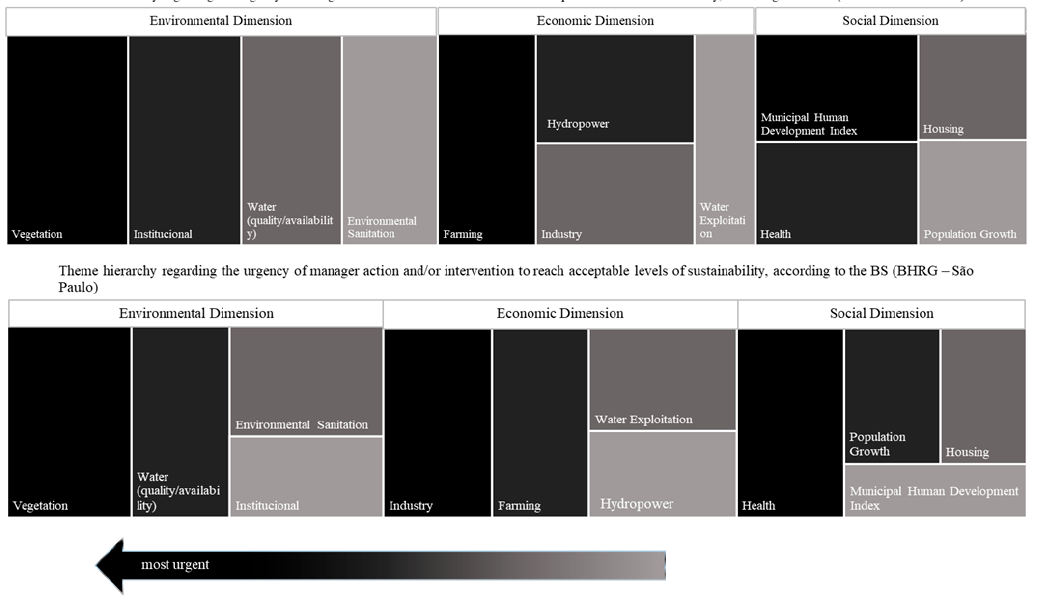
Figure 7. Hierarchy of vulnerable thematic areas at BHRG, separated by sustainable development dimension and by state. The darker tones and the direction of the arrow represent thematic area vulnerability and dimension, respectively.